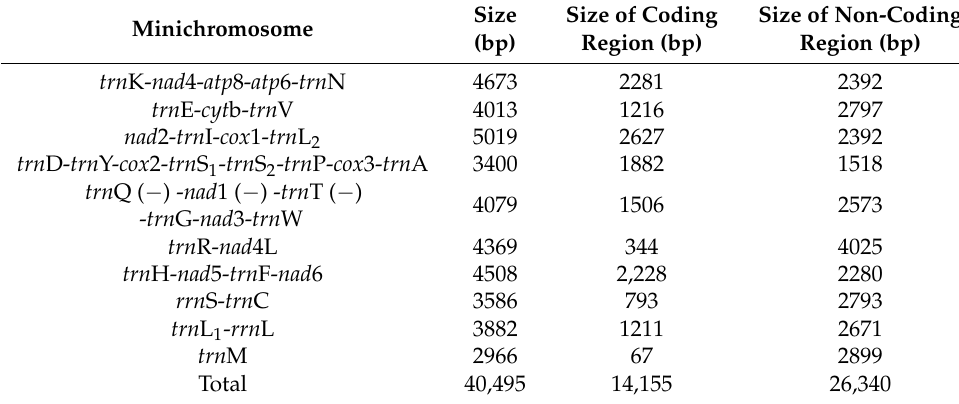
Figure 1. The complete mitochondrial genome of the buffalo louse, Haematopinus tuberculatus . Each minichromosome has a coding region and a non-coding region (NCR, in black). The names and transcript orientation of genes are indicated in the coding region and the minichromosomes are in alphabetical order of protein-coding genes and rRNA genes. Abbreviations: atp 6 and atp 8, ATP synthase F0 subunits 6 and 8; co b, cytochrome b; cox 1–3, cytochrome c oxidase subunits 1–3; nad 1–6 and nad 4L, NADH dehydrogenase subunits 1–6 and 4L; rrn S and rrn L, small and large subunits of ribosomal RNA. tRNA genes are indicated with their single-letter abbreviations of the corresponding amino acids. Table 1. Mitochondrial minichromosomes of the buffalo louse Haematopinus tuberculatus , determined by next-generation sequencing using Illumina.